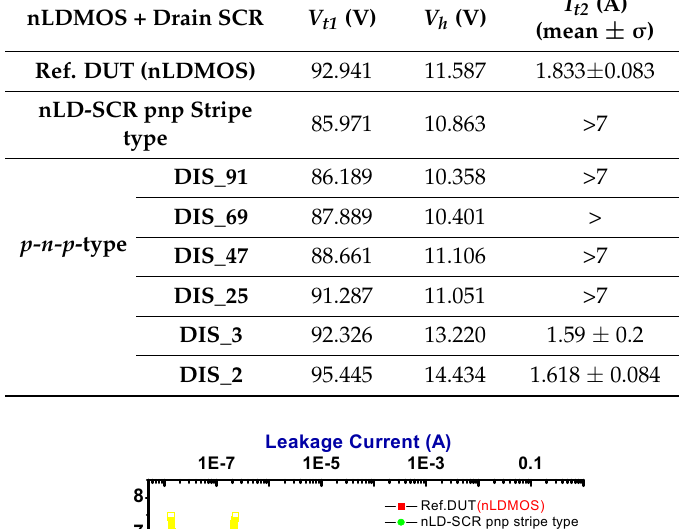
Table 2. Snapback key parameters of the nLDMOS-SCR ( p-n-p -arranged) tested samples.